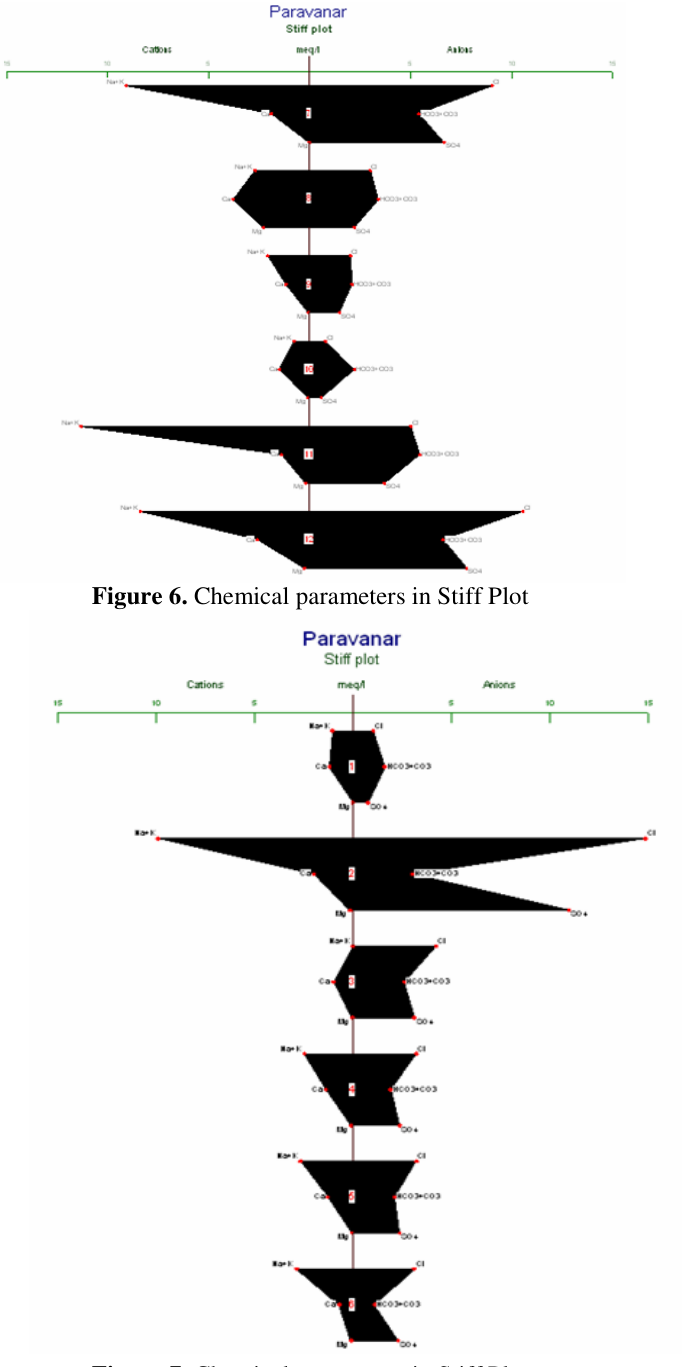
Figure 7. Chemical parameters in Stiff